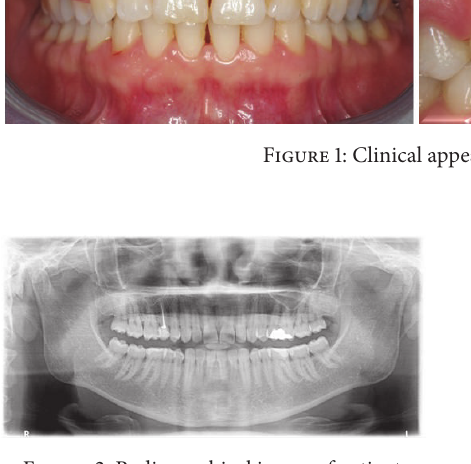
Figure 2: Radiographical image of